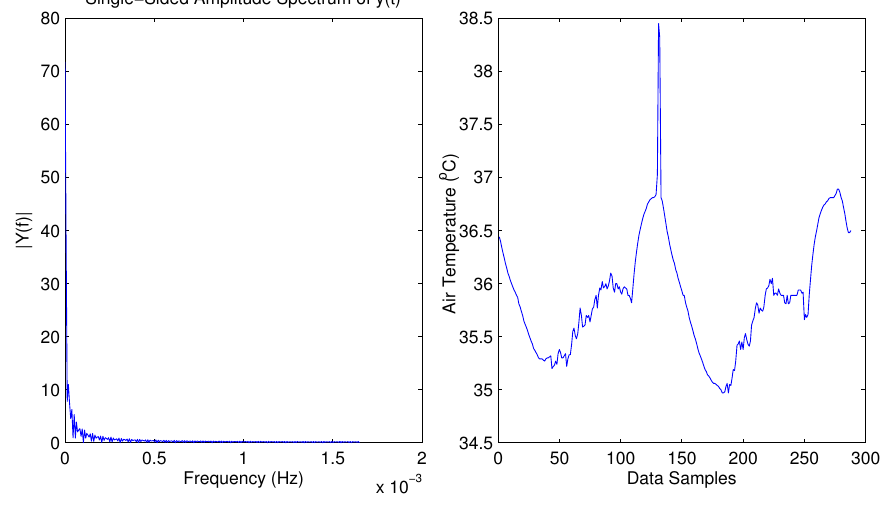
Figure 5. Compressibility of wildfire data-trace.